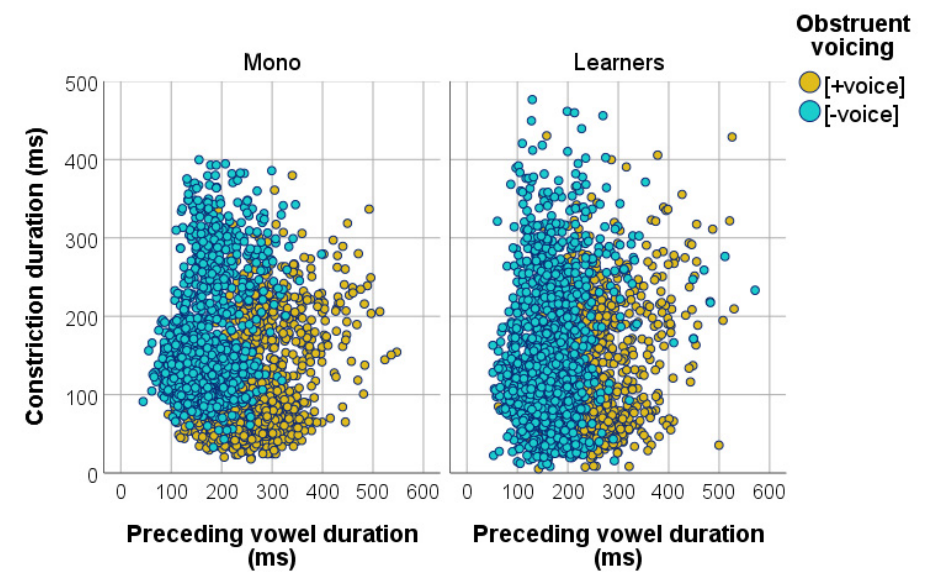
Figure 14. Scatterplot of constriction duration and preceding vowel duration for final stops and fricatives in English speech of monolingual controls and learners.